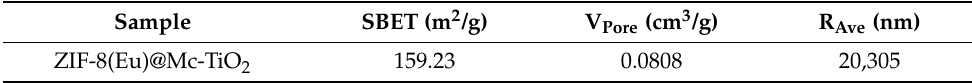
Table 1. ZIF-8(Eu)@Mc-TiO 2 -specific surface area and pore size values. Sample